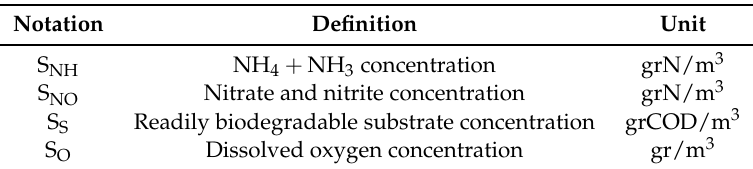
Table 1. List of state variables of the